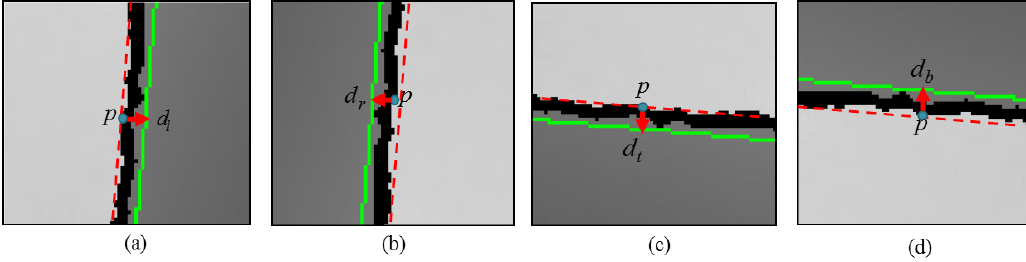
Figure 8. Illustration of hole pixels (black) and their nearby edges (green). Depending on the position of the nearby edges, four different directional hole filling operations are